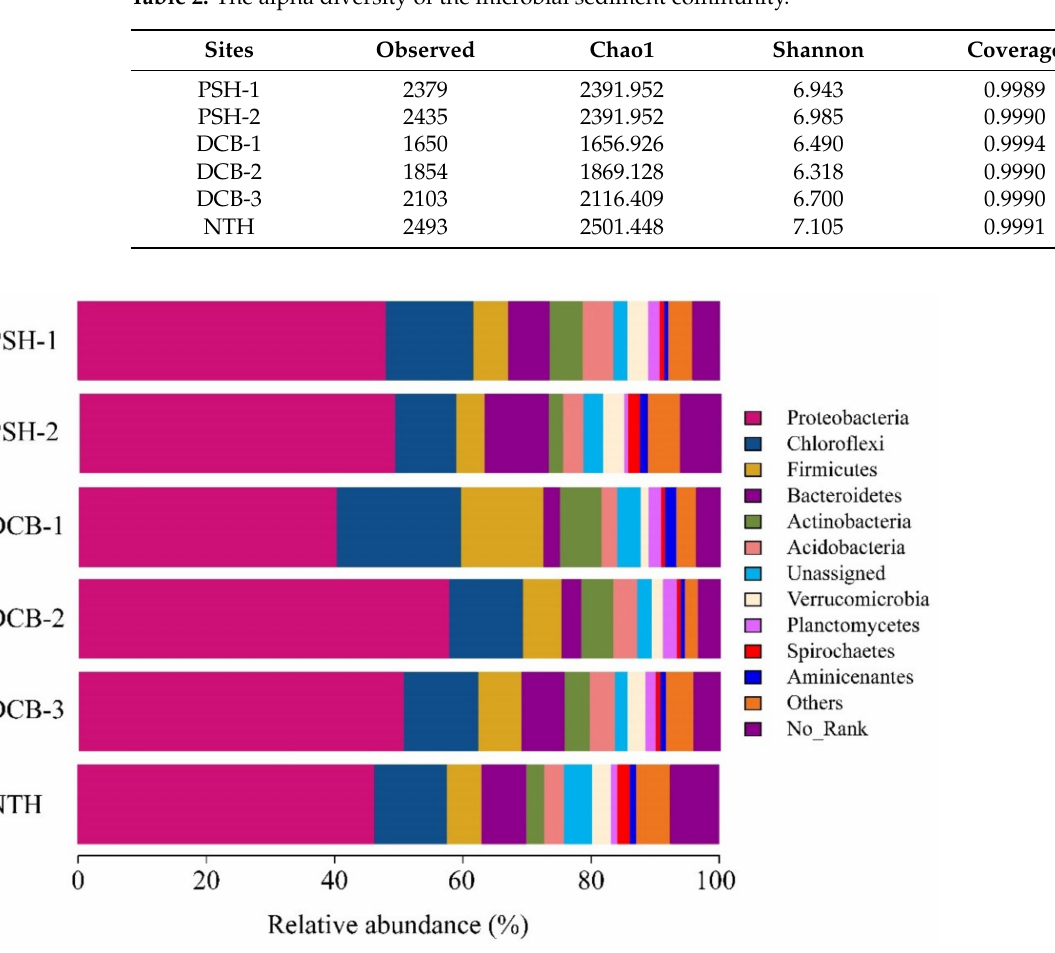
Figure 4. Relative abundance of sediment bacteria community composition at the phylum